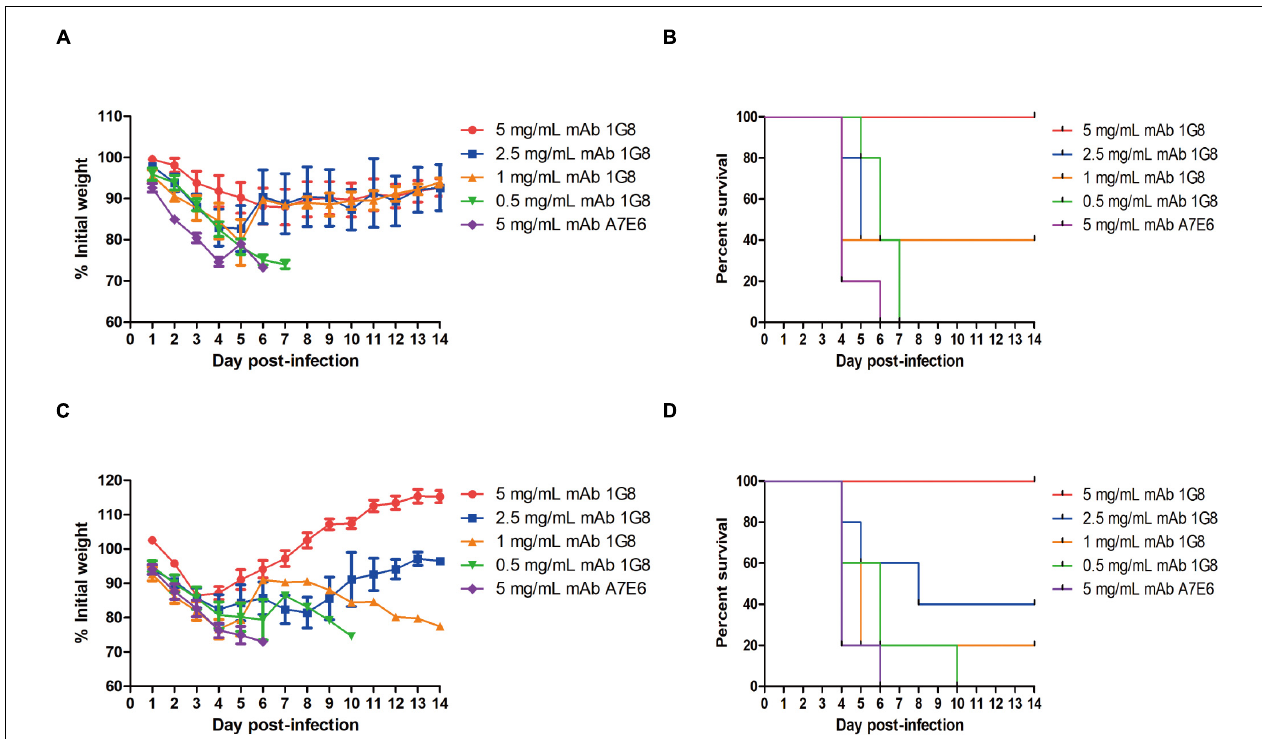
FIGURE 3 | In vivo protective effect of mAb 1G8 in therapeutic experiment. (A) The mean percentage of mice body weight of BALB/c mice ( n = 5 per group) challenged with 10 8 TCID 50 rgH1N2(JSH1) viruses and treated with mAb 1G8 (5, 2.5, 1, and 0.5 mg/kg) or mAb A7E6 (5 mg/kg). (B) The survival curves of BALB/c mice ( n = 5 per group) challenged with 10 8 TCID 50 rgH1N2(JSH1) viruses and treated with mAb 1G8 (5, 2.5, 1, and 0.5 mg/kg) or mAb A7E6 (5 mg/kg). (C) The mean percentage of body weight of BALB/c mice challenged with 10 8 TCID 50 rgH1N2(PUMCH06) viruses and treated with mAb 1G8 (5, 2.5, 1, and 0.5 mg/kg) or mAb A7E6 (5 mg/kg). All data were performed with Graphpad Prism 5 and represented as mean ± SEM. (D) The survival curves of BALB/c mice challenged with 10 8 TCID 50 rgH1N2(PUMCH06) viruses and treated with mAb 1G8 (5, 2.5, 1, and 0.5 mg/kg) or mAb A7E6 (5